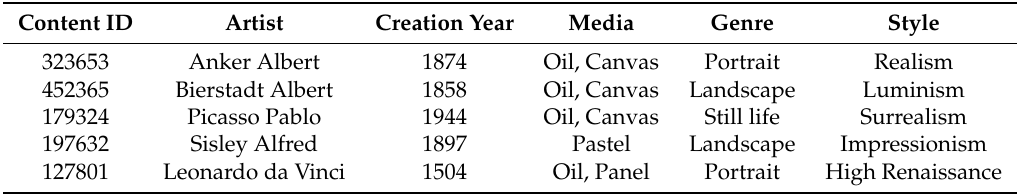
Table 2. Dataset